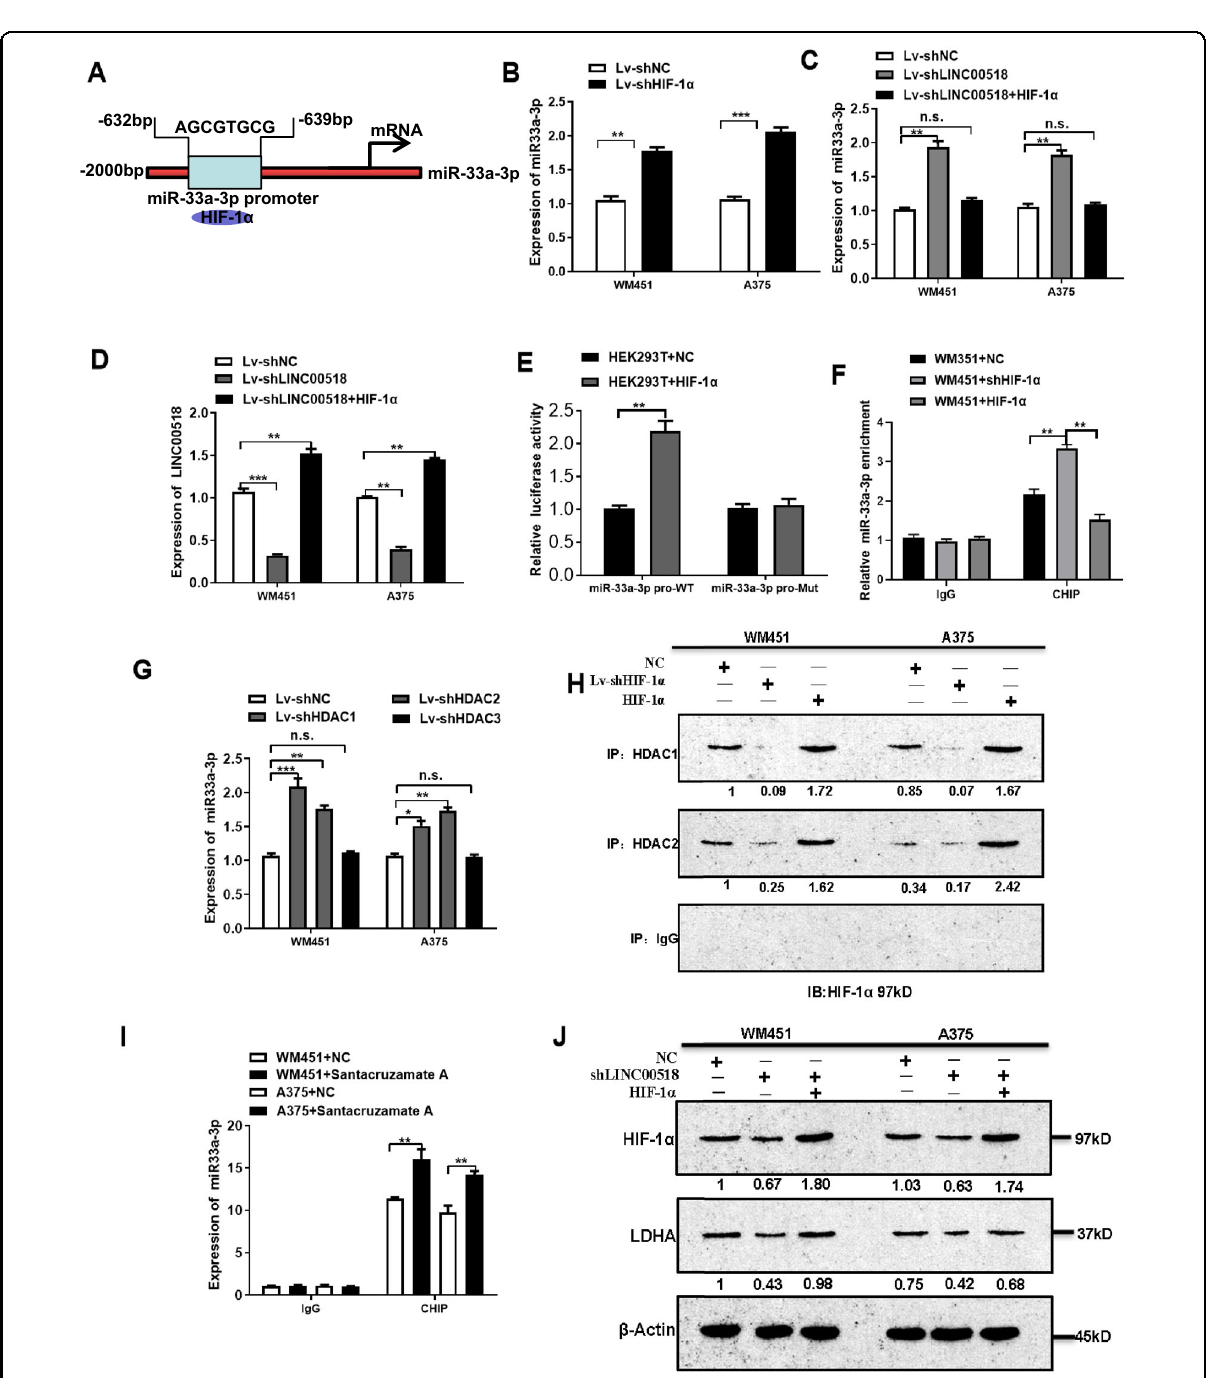
Fig. 4 HIF-1 α negatively regulates miR-33a-3p expression in CMM cells. A JASPAR predicted the binding sites of the HIF-1 α and LINC00518 promoter regions. B qRT-PCR showing that the expression of miR-33a-3p was signi fi cantly increased after HIF-1 α knockout. C , D The expression changes of miR-33a-3p and LINC00518 after transfected with shHIF-1 α , shLINC00518 or shLINC00518 plus HIF-1 α overexpression. E Dual-luciferase assay showing the luciferase activity in HEK293T cells cotransfected with wild-type (Wt) or mutant (Mut) HIF-1 α in the miR-33a-3p promoter region. F ChIP PCR indicated that the miR-33a-3p promoter region bound to HIF-1 α . G qRT-PCR showing miR-33a-3p expression levels after HDAC1, HDAC2, HDAC3 knockout in CMM cells. H CoIP assay showed that the HIF-1 α -HDAC immunoprecipitate was decreased after HIF-1 α knockdown and increased after HIF-1 α overexpression. I ChIP PCR showing that Santacruzamate A (inhibiting histone deacetylation) could recover the relative expression levels of miR-33a-3p in WM451 and A375 cells; immunoglobulin G (IgG) acted as the NC. J Western blotting analysis, indicating that LINC00518 knockdown decreased HIF-1 α and LDHA protein levels, while overexpression of HIF-1 α in LINC00518 knockdown cells enhanced HIF-1 α and LDHA expression. The histogram data for each group are an average of three independent replicates; bars indicate SD; * P < 0.05, ** P < 0.01, *** P <